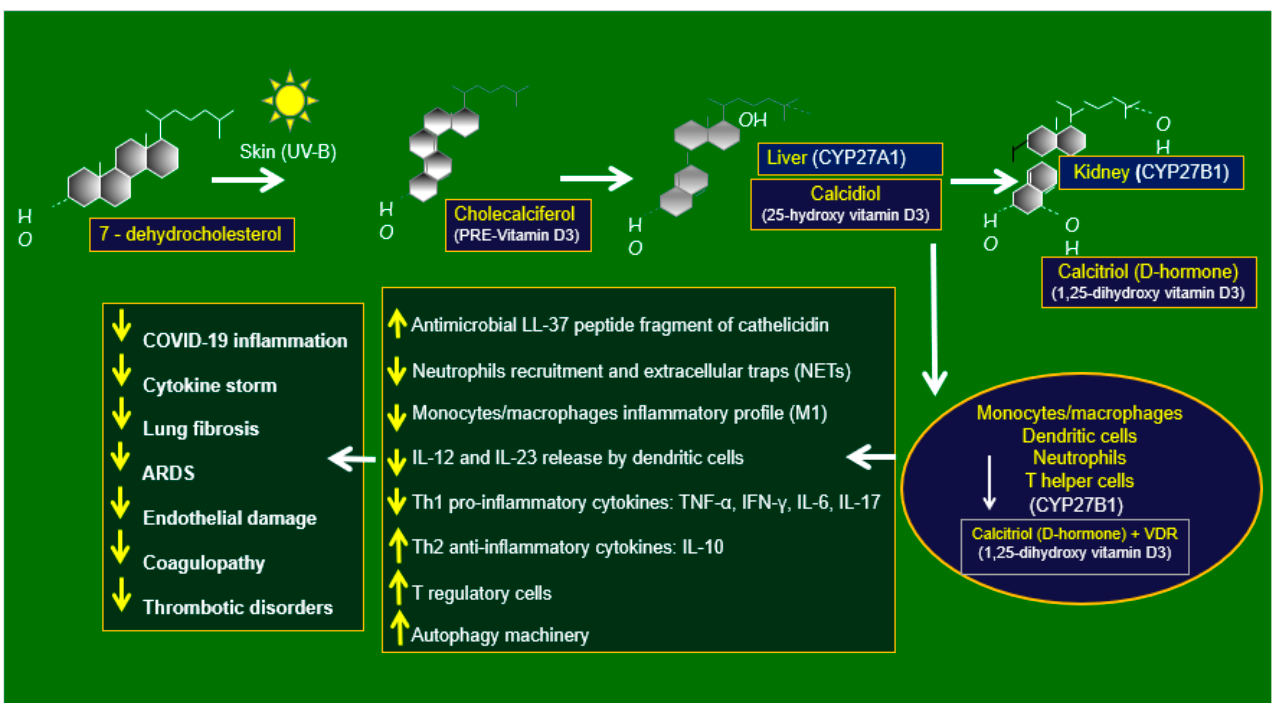
Figure 1. Vitamin D effects on immune system in course of COVID-19. ARDS: acute respiratory distress syndrome; IFN- γ : interferon gamma; IL-6: interleukin 6; IL-10: interleukin 10; IL-12: interleukin 12; IL-17: interleukin 17; IL-23: interleukin 23; NETs: neutrophil extracellular traps; Th1: T helper 1; Th2: T helper 2; TNF- α : tumor necrosis factor α ; UV-B: ultraviolet B.